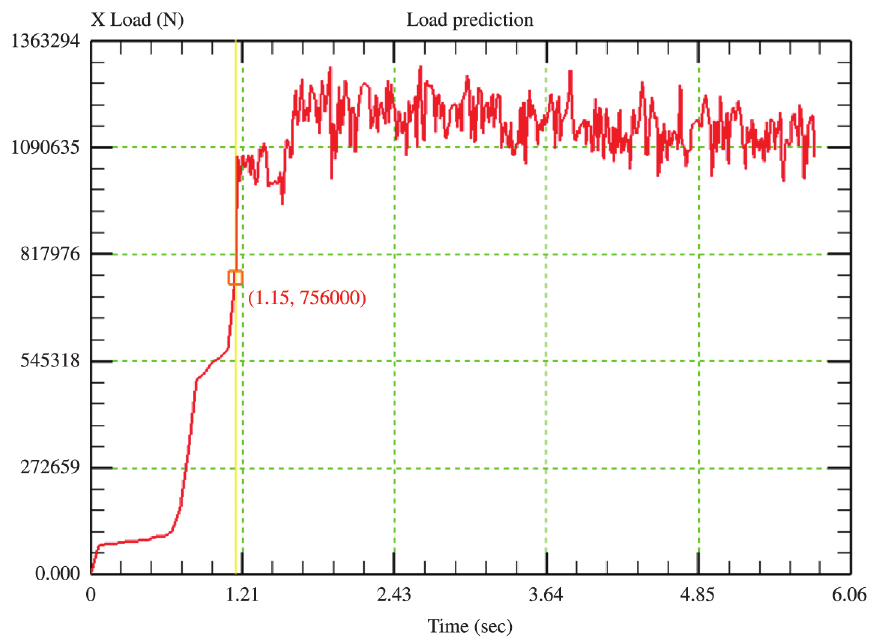
Figure 5. The extrusion loads during ES